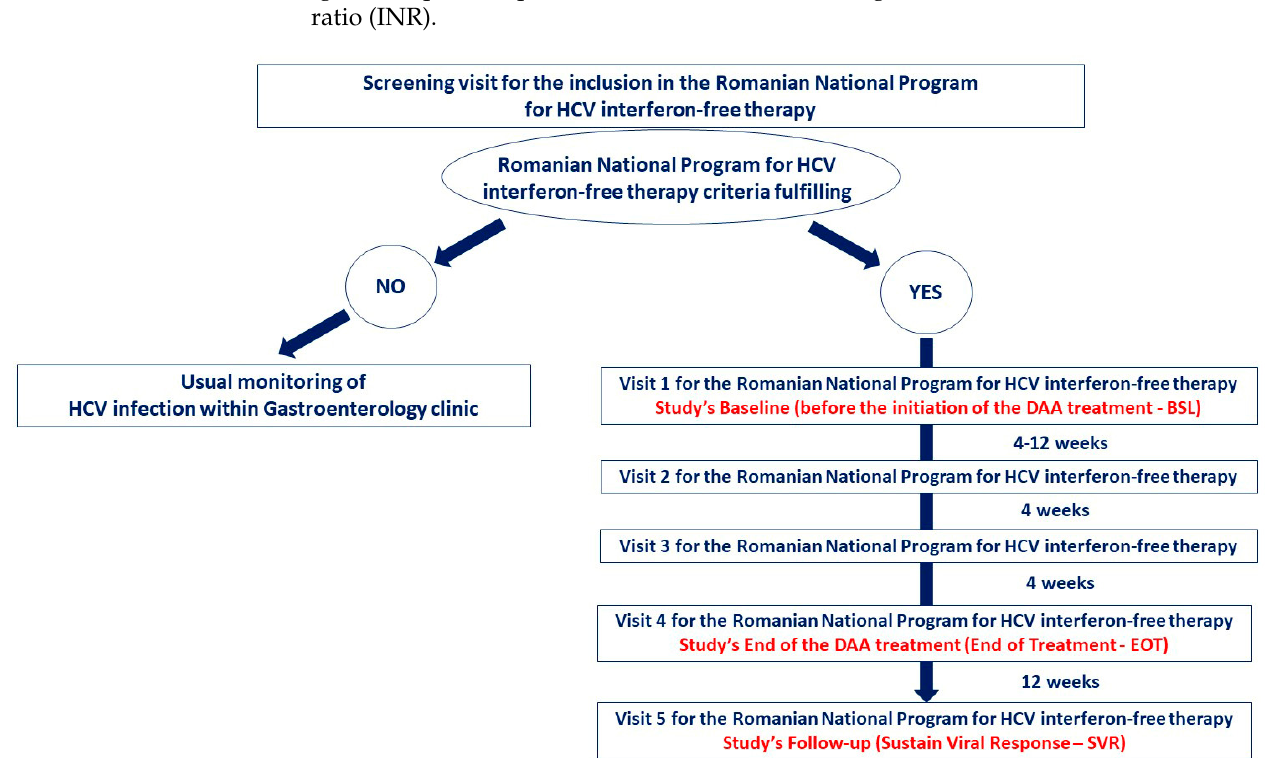
Figure 1. Patients flow diagram for the whole process of DAAs intervention. The study arm consisted of 90 subjects from BSL to SVR.